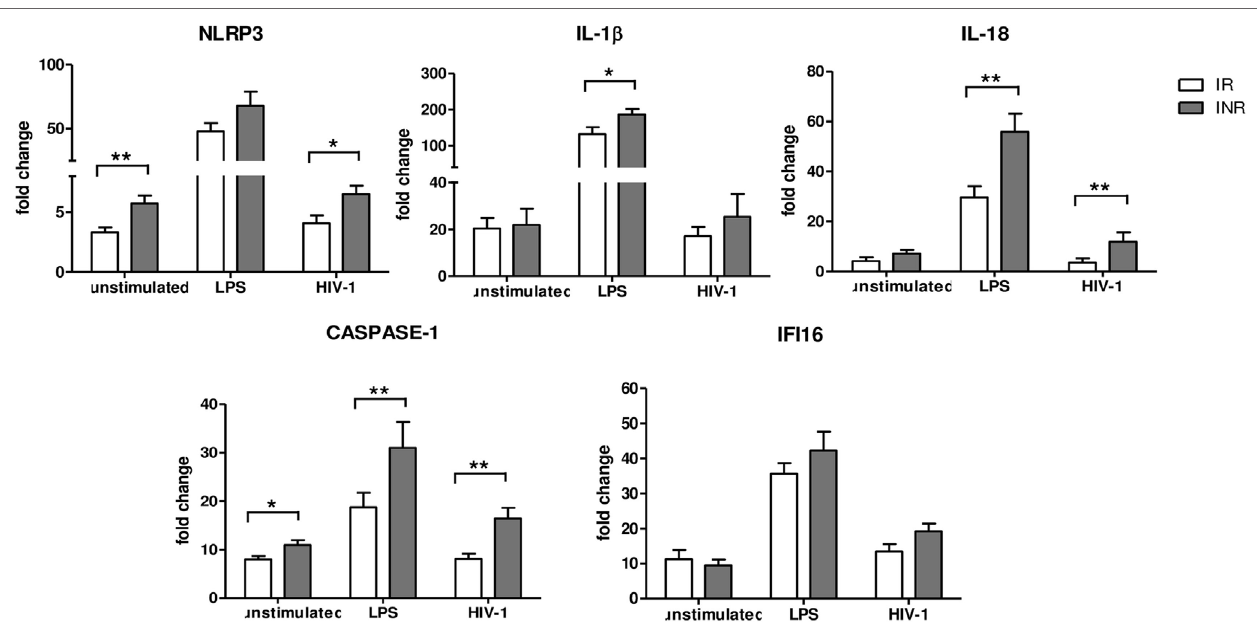
FigUre 2 | Inflammasome and pyroptosis gene expression. NLRP3, IL1 β , IL-18, Caspase-1, and γ -interferon-inducible protein 16 (IFI16) expressions were quantified in peripheral blood mononuclear cells (PBMCs) from each patient enrolled in the study ( n = 22 for IRs and n = 17 for INRs) either unstimulated or LPS or AT2-treated-HIV-1 BaL stimulated. White bars represent IRs, gray bars represent INRs. Mean values and SEM are shown. * p < 0.05; ** p < 0.02. Fold change expressed as 2 Δ Δ Ct